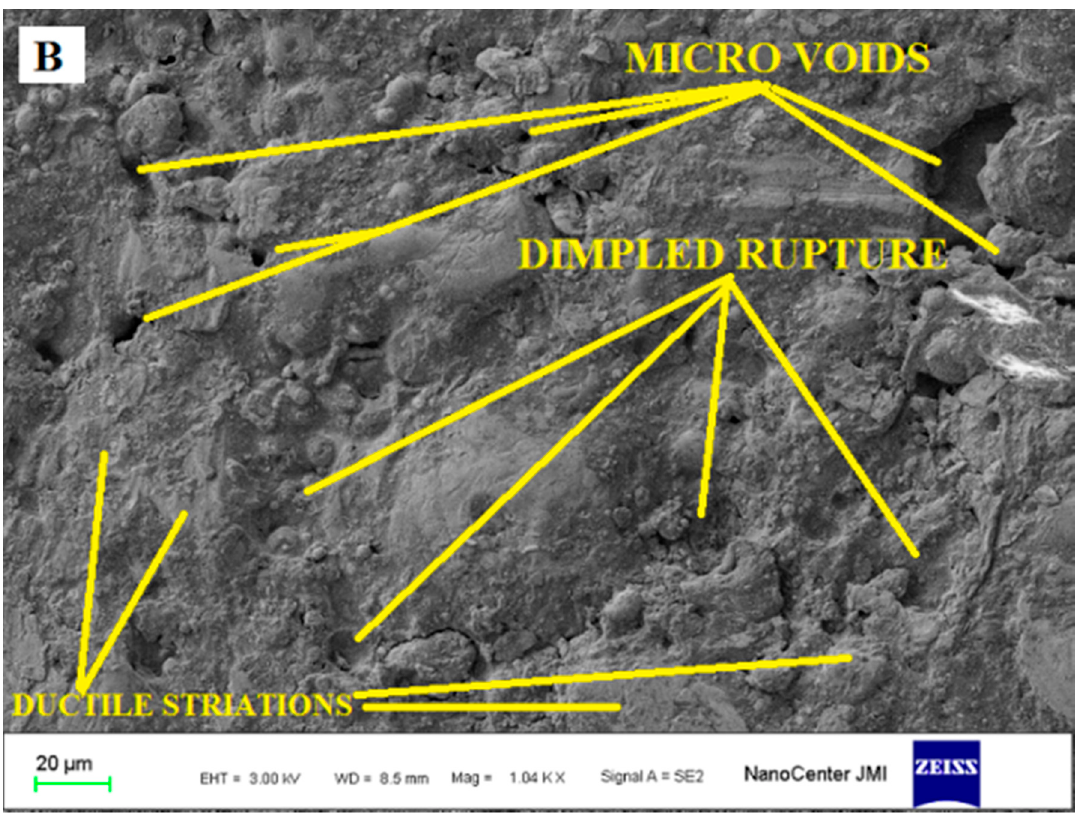
Figure 10. SEM fractography of the welded joints produced by ( A ) tapered cylindrical pin for buttjoint configuration and ( B ) cylindrical pin for scarf joint configuration.